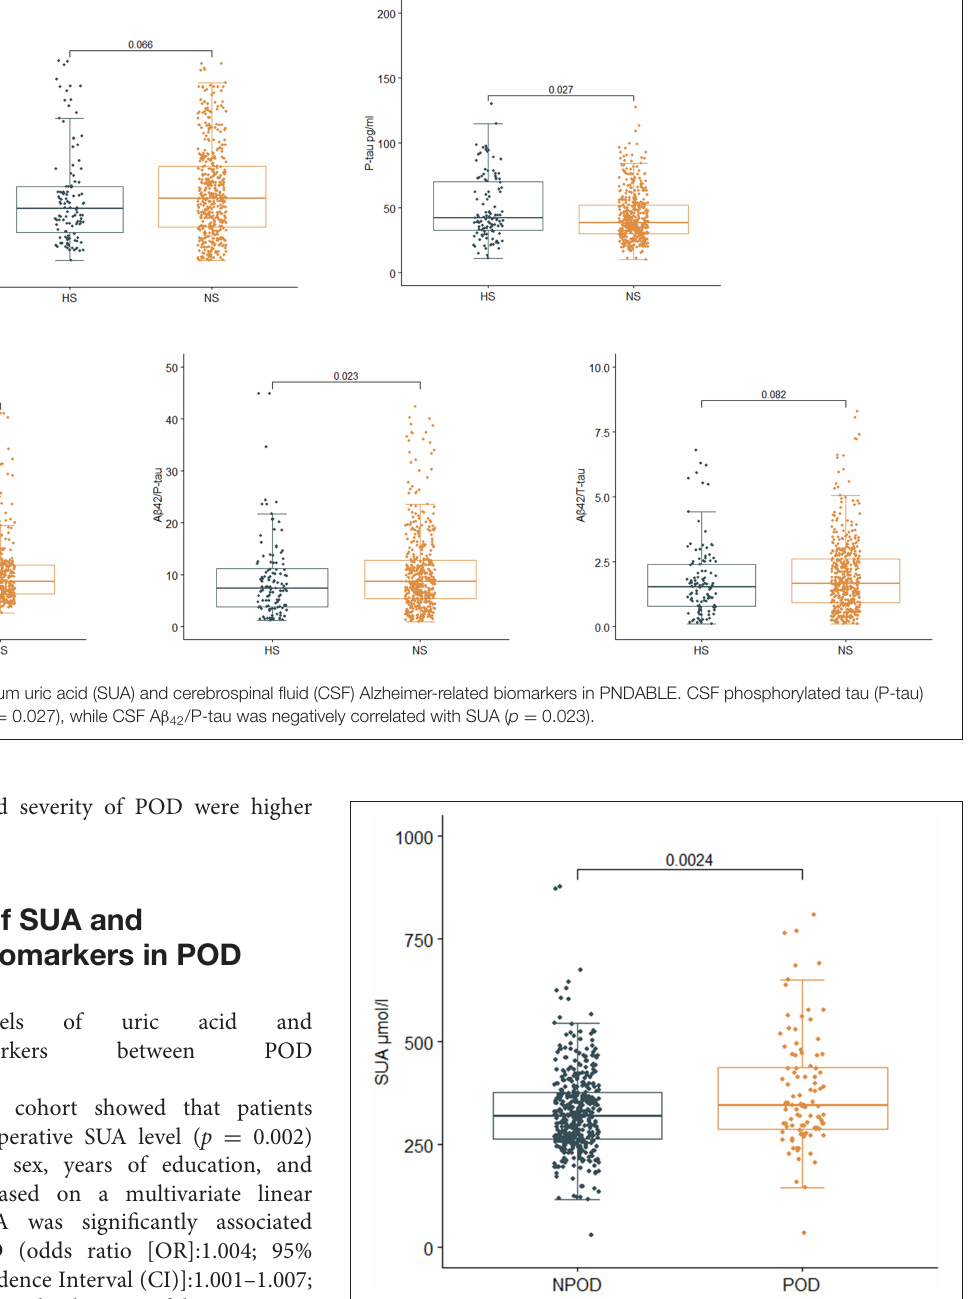
FIGURE 3 | Relationship between SUA and postoperative delirium (POD) in Perioperative Neurocognitive Disorder Risk Factor and Prognosis (PNDRFAP). The incidence of POD was positively correlated with SUA ( p =